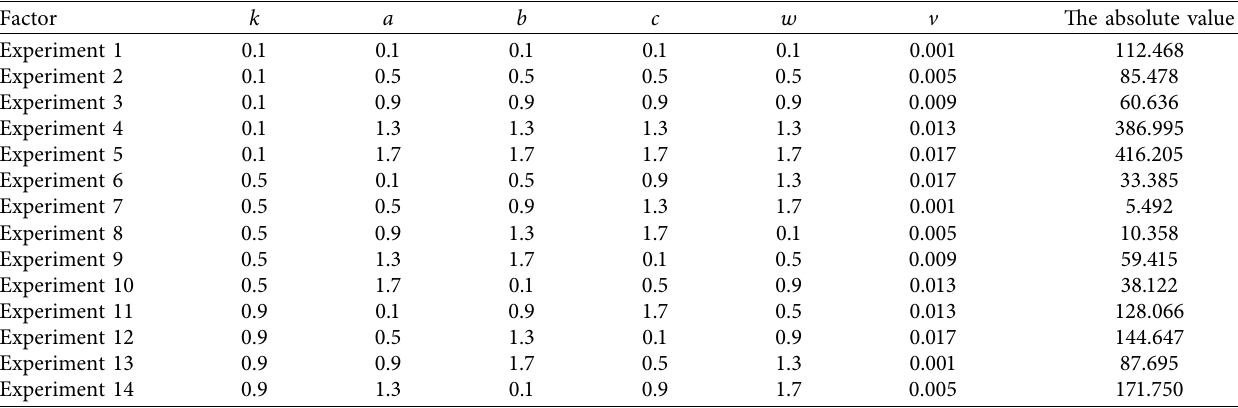
Table 3: Sum of errors between numerical simulation and measurement under different numerical simulation experimental schemes. Factor